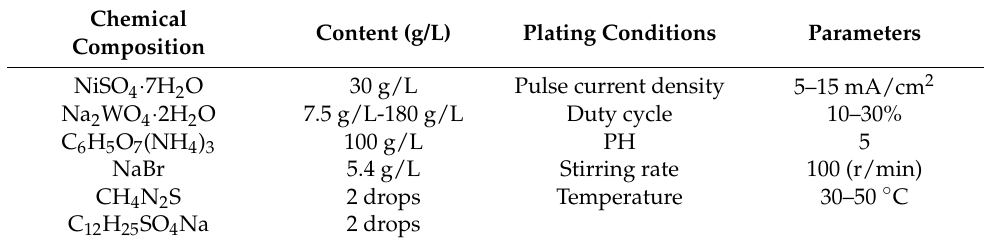
Table 1. Chemical composition and plating